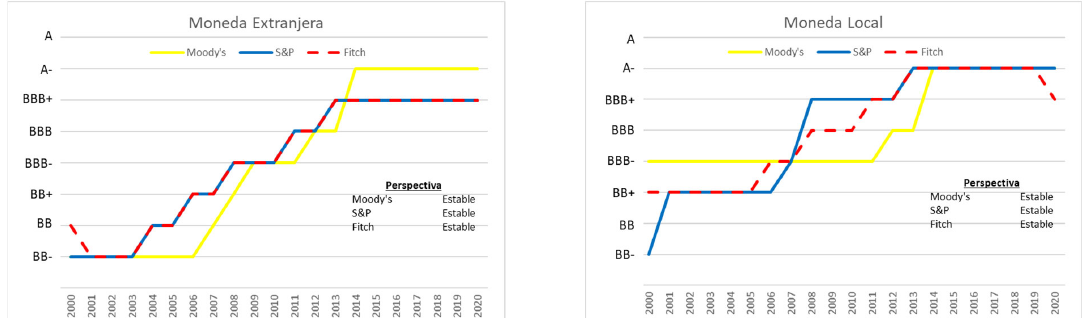
Fig. 1. Risk rating of sovereign debt in local currency 2000 -